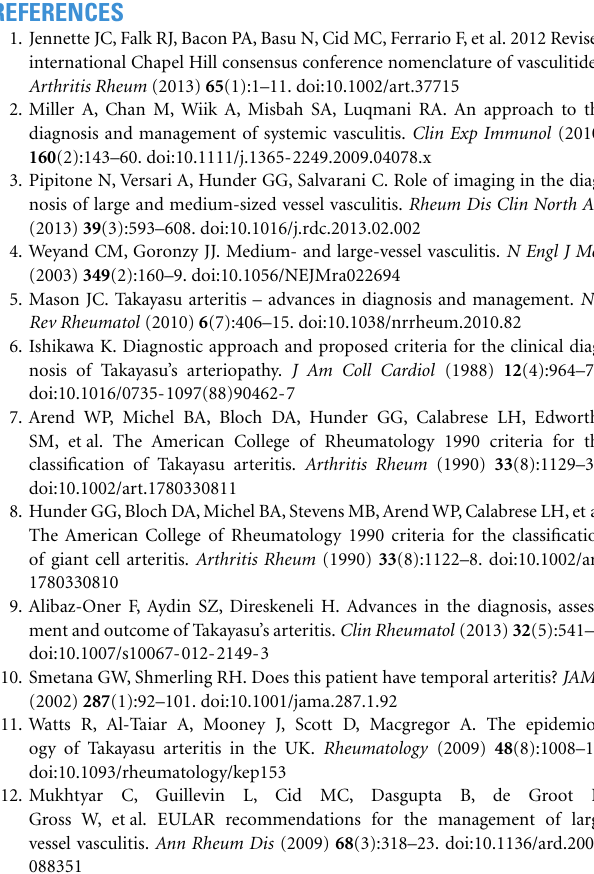
FIGURE 7 | Proposed guidelines-based algorithm for imaging evaluation of patients with large-vessel vasculitis . GCA: giant cell arteritis;TAK: Takayasu arteritis;TAB: temporal artery biopsy. *Atypical presentations for